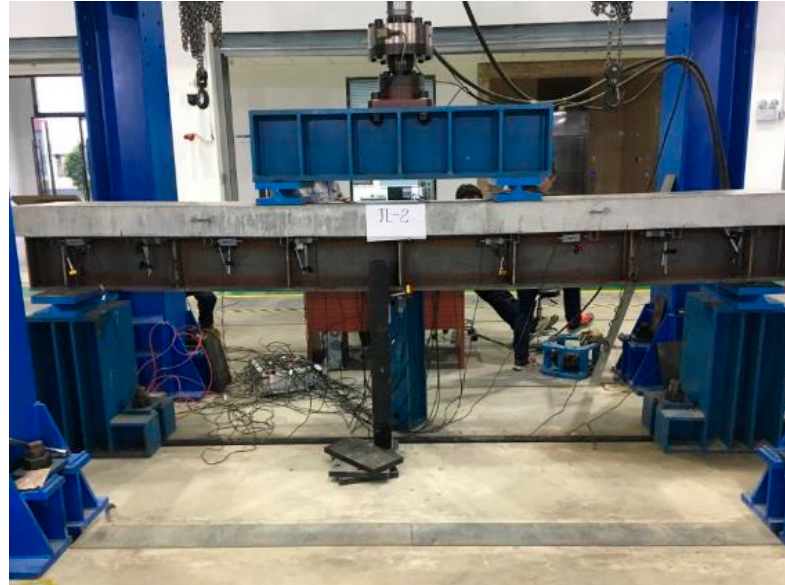
Figure 10. Deformation capacity of Beam 2 at failure.